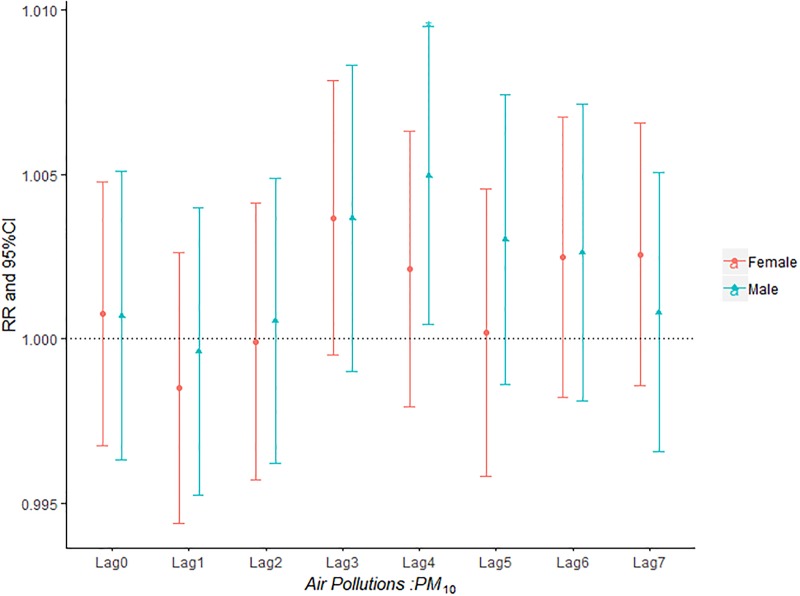
The effect of PM10 on the relative risk of AECOPD based on the stratification of gender.